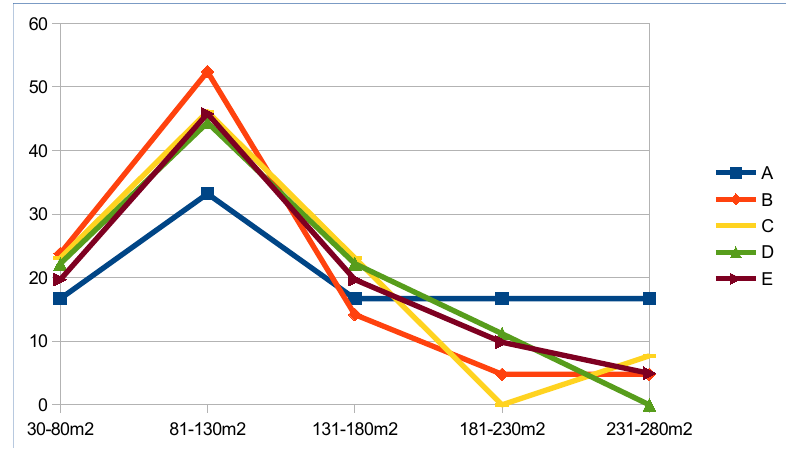
Fig. 8. Size of BKK houses divided into five size